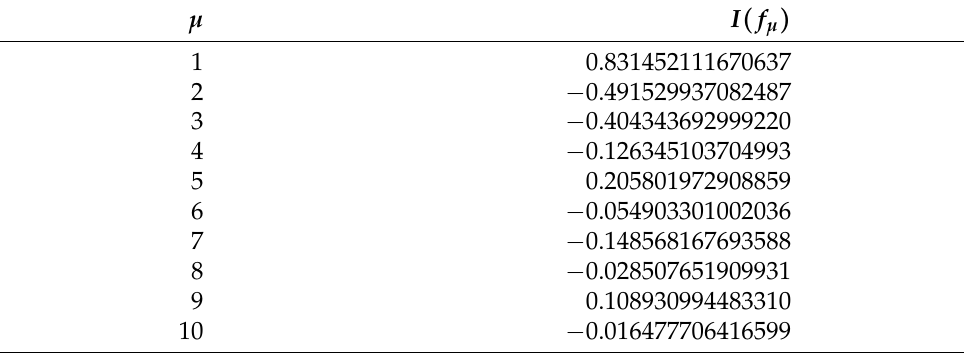
Table 1. Test Case 6: exact value of the integral of the function f µ ( x ) for µ = 1, . . . ,10. µ I ( f µ